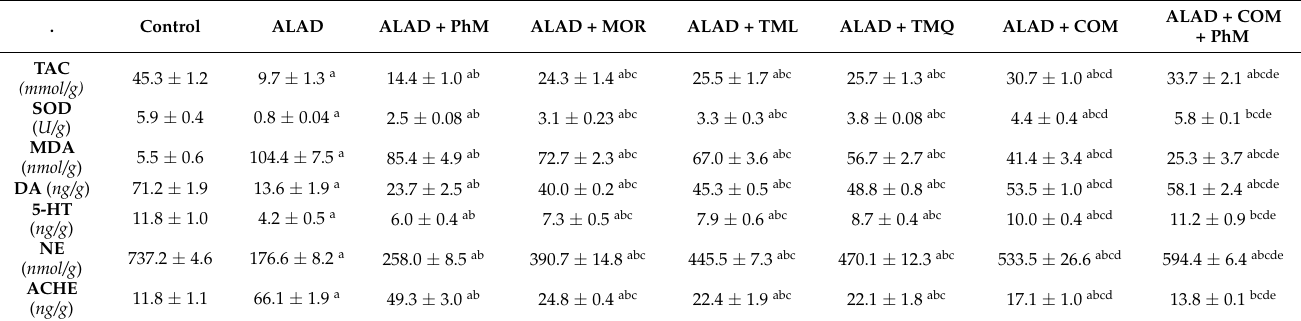
Table 2. The effect of phytochemical combinations, MOR, TML, and TMQ, with PhM on oxidative stress, neurotransmitter decline and ACHE elevation induced by AlCl 3 administration in rats for five weeks (70 mg/kg/day,